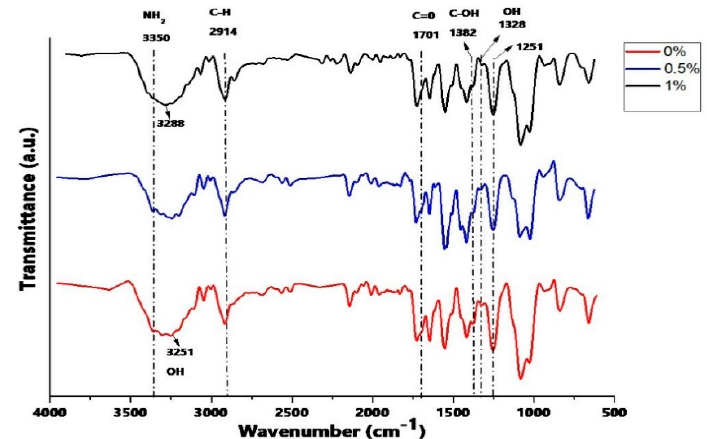
Figure 1. Attenuated total reflectance Fourier-transform infrared spectroscopy (ATR-FTIR) of electrospun chitosan (CS)/polyvinyl alcohol (PVA)/graphene oxide (GO) composite nanofibrous membranes with different GO amounts (0%, 0.5%, and 1.0%).